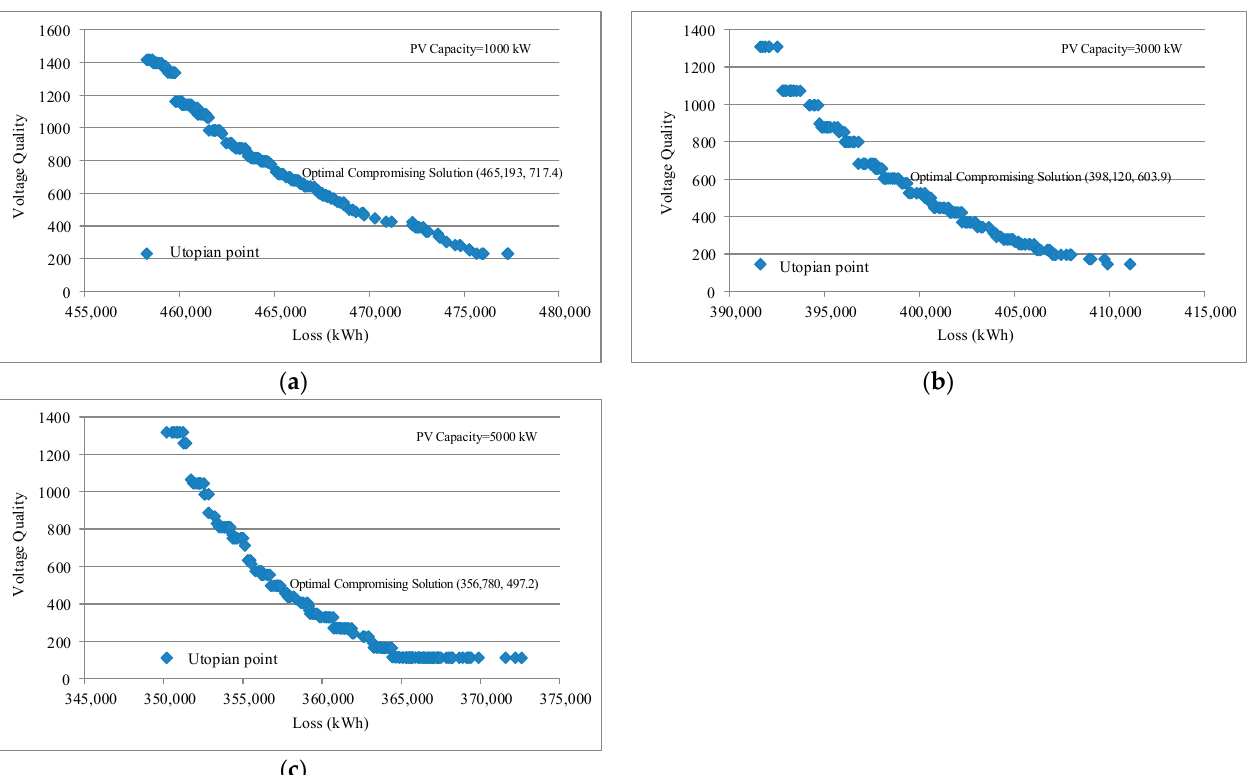
Figure 7. Pareto frontiers for the PV target installed capacity of 1000, 3000, and 5000 kW. ( a ) PV installed capacity 1000 kW; ( b ) PV installed capacity 3000 kW; ( c ) PV installed capacity 5000 Table 2. Summary of the optimal compromising solution, optimal loss solution, and optimal voltage quality solution.